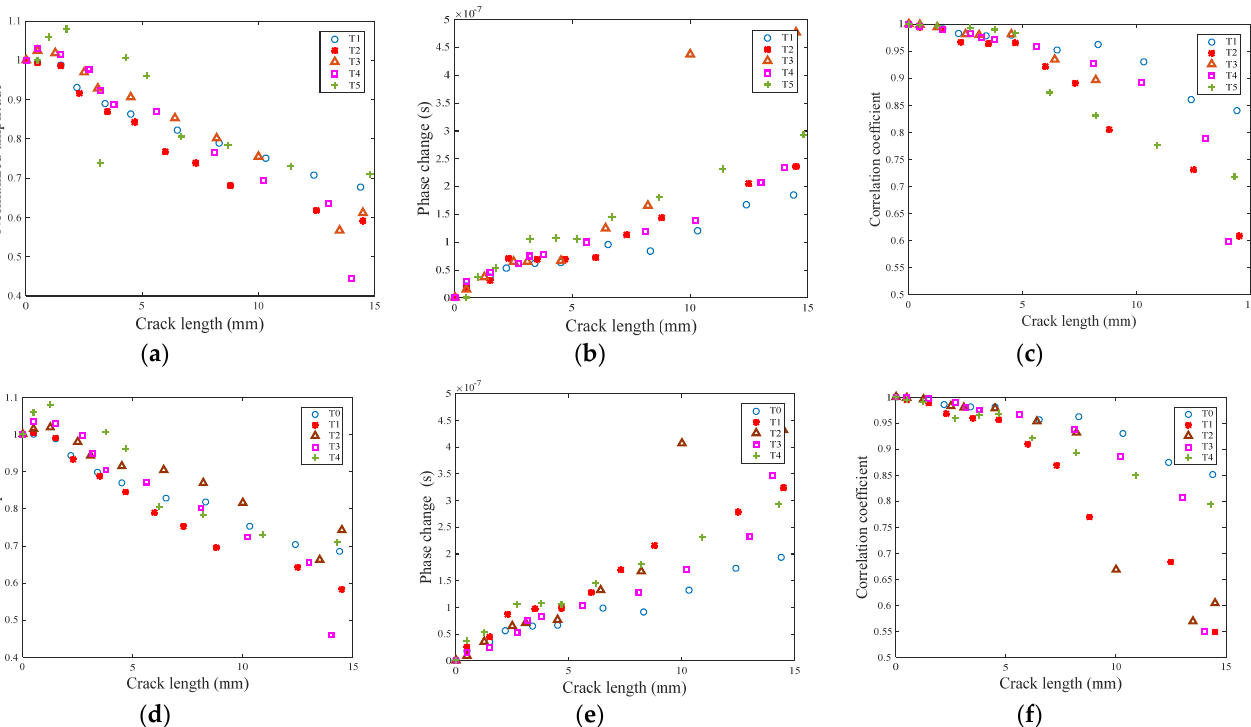
Figure 19. Damage features of specimens: ( a ) normalized amplitude of 300~700 kHz L-Chip; ( b ) phase change of 300~700 kHz L-Chip; ( c ) correlation coefficient of 300~700 kHz L-Chip; ( d ) normalized amplitude of 500 kHz GCC; ( e ) phase change of 500 kHz GCC; and ( f ) correlation coefficient of 500 kHz GCC.